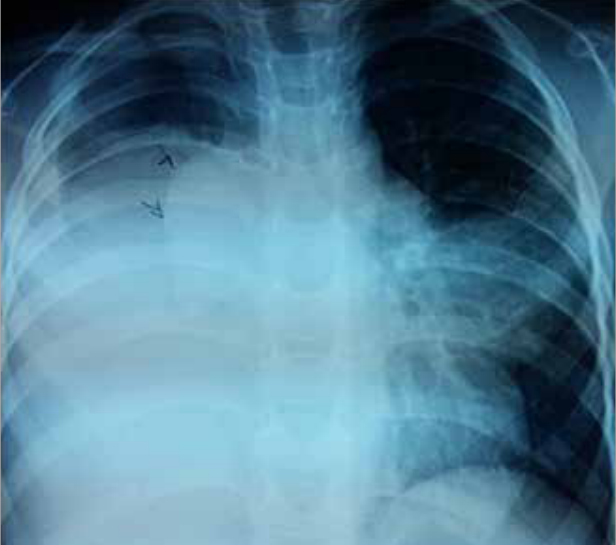
Fig 1. A large homogenous opacity involving middle and lower zone of right lung field and opacity in the mid zone of left lung field